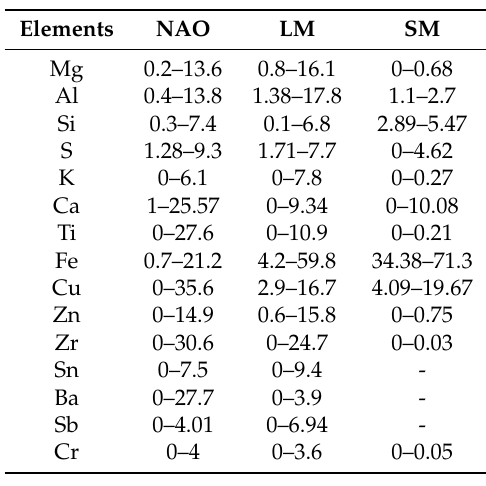
Table 6. Element weight percentages for brake pads from selected studies: non-asbestos organic (NAO) [17,44,52,89,130], low-metallic (LM) [17,52,58,89,92,125,130,131] and semi-metallic (SM)